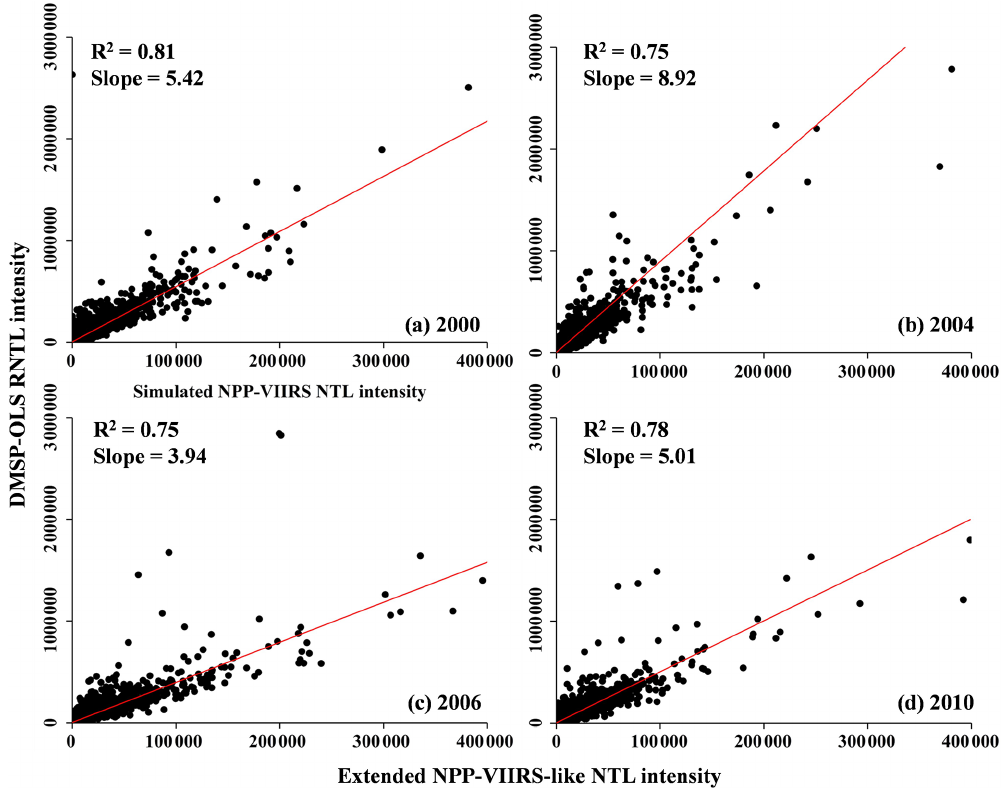
Figure 7. The comparison between the annual DMSP-OLS RNTL intensity (DN Value) and extended NPP-VIIRS-like NTL intensity (unit: nWcm − 2 sr − 1 ) at the city level in (a) 2000, (b) 2004, (c) 2006, and (d) 2010.